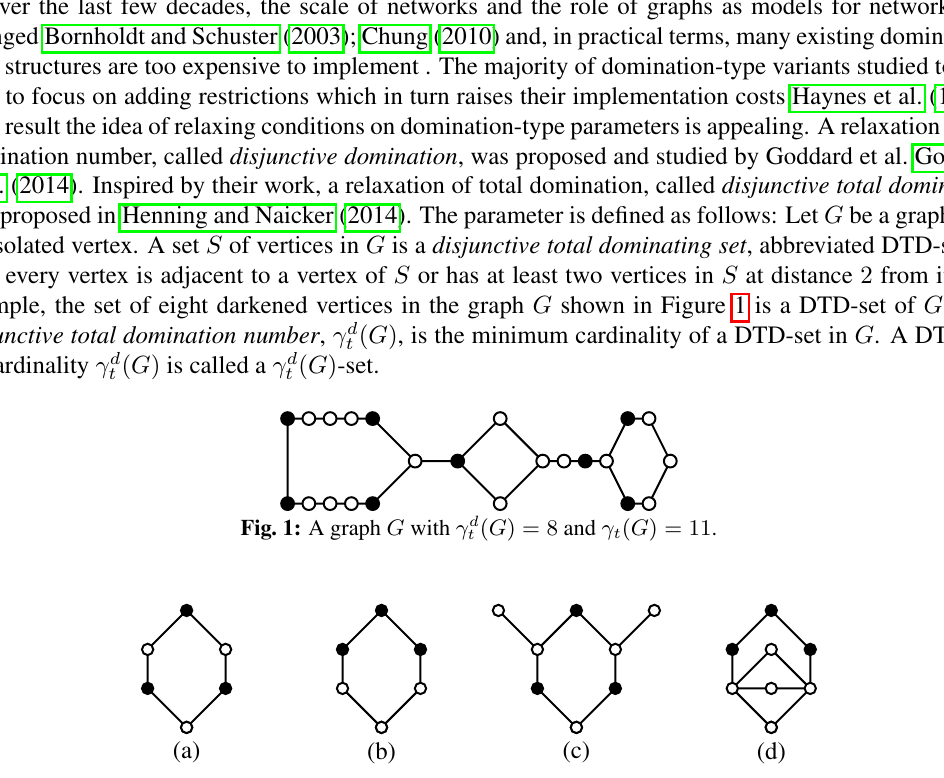
Fig. 2: Novel features of